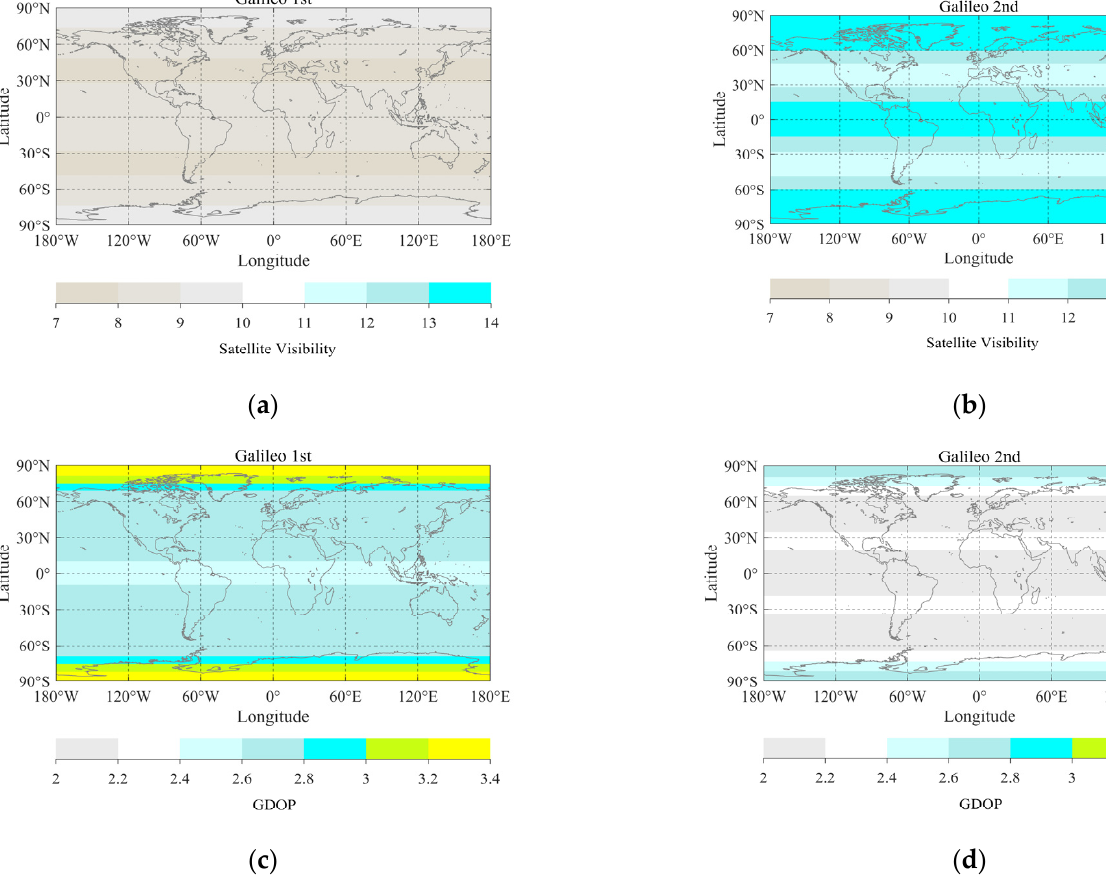
Figure 3. Satellite visibility and GDOP of Galileo: ( a ) visible satellites of Galileo 1st generation; ( b ) visible satellites of Galileo 2nd generation; ( c ) GDOP of Galileo 1st generation; ( d ) GDOP of Galileo 2nd generation.